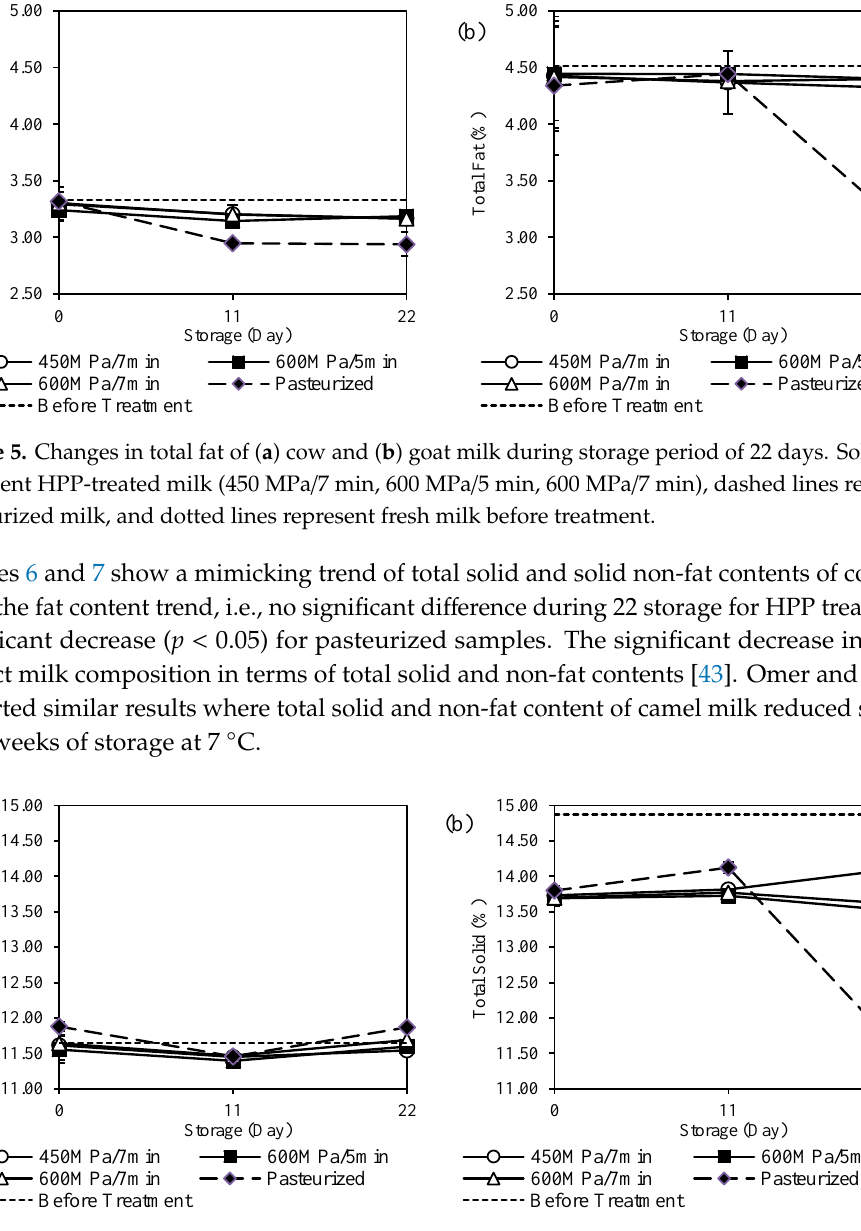
Figure 4. Changes in total protein of ( a ) cow and ( b ) goat milk during storage period of 22 days. Solid lines represent HPP-treated milk (450 MPa/7 min, 600 MPa/5 min, 600 MPa/7 min), dashed lines represent pasteurized milk and dotted lines represent fresh milk before treatment.